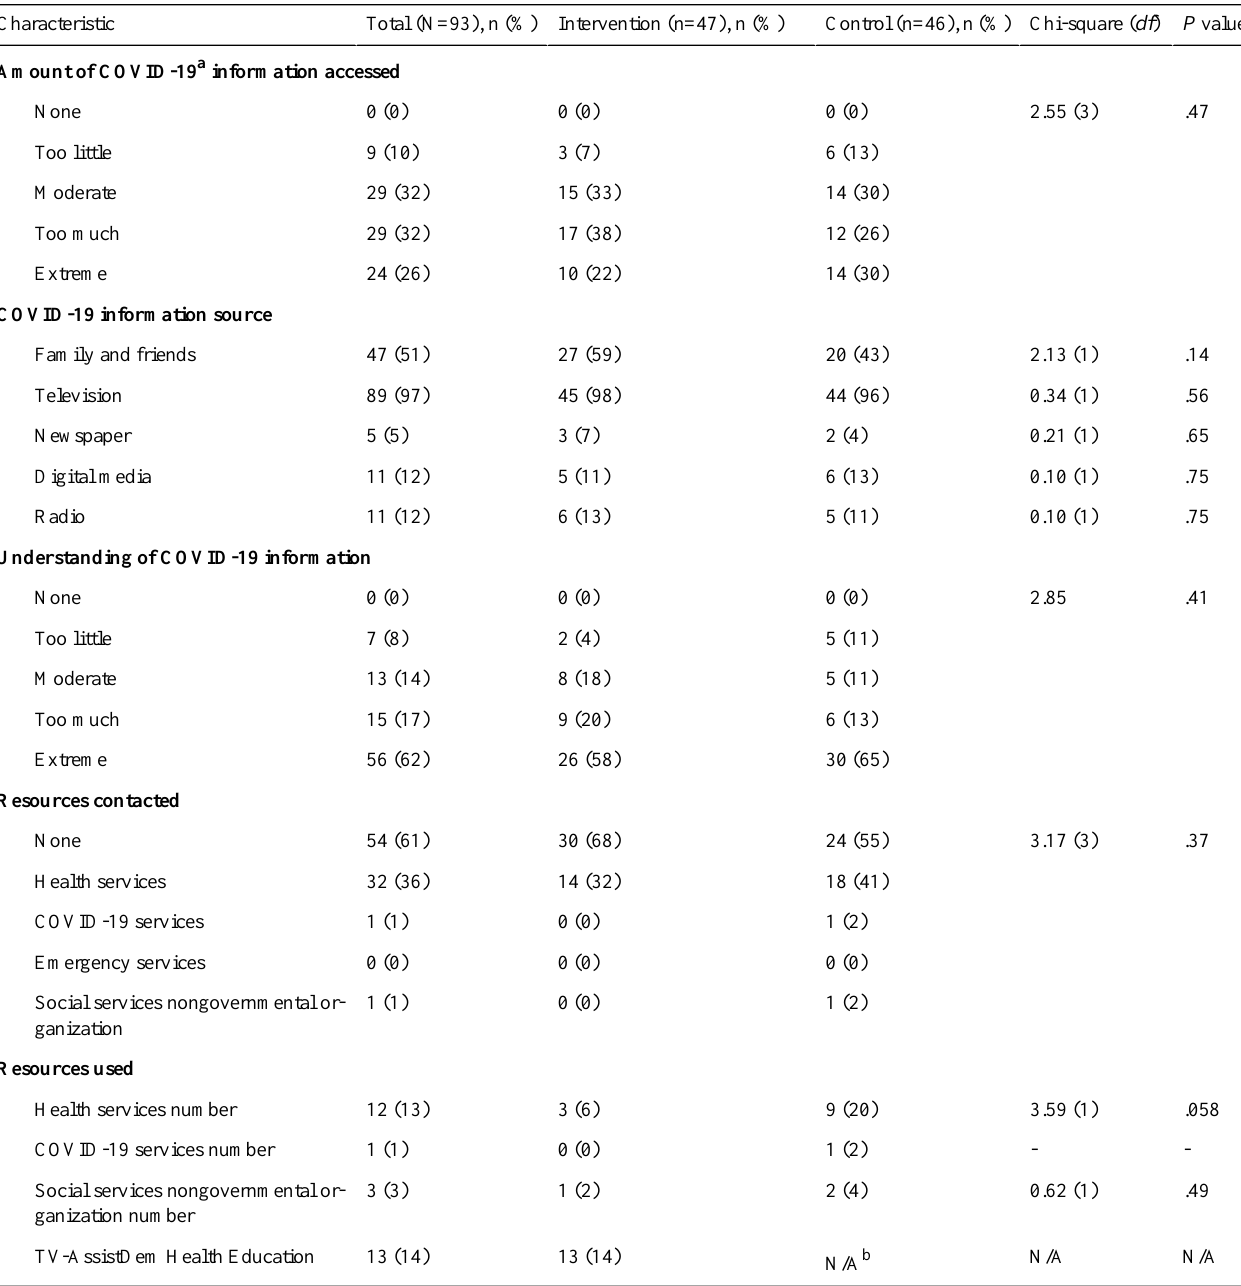
Table 4. Differences between the intervention and control groups regarding information and resources pertaining to the COVID-19